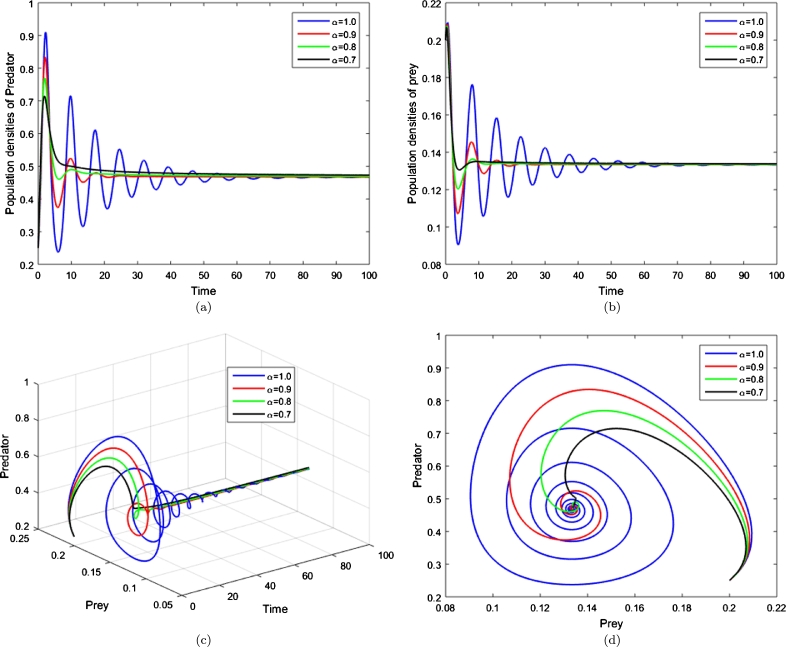
The damping of population oscillations produced by system (4) with initial densities (0.2,0.25) and ψ = 19, ρ = 1, ψ = 15, ϕ = 2, ε1 = 0.4 and ε2 = 1. (a and b) Numerical values of the lanternfish and tuna versus time respectively. (c): Combined predator-prey population densities with respect to time and (d): Phase portrait of the system.